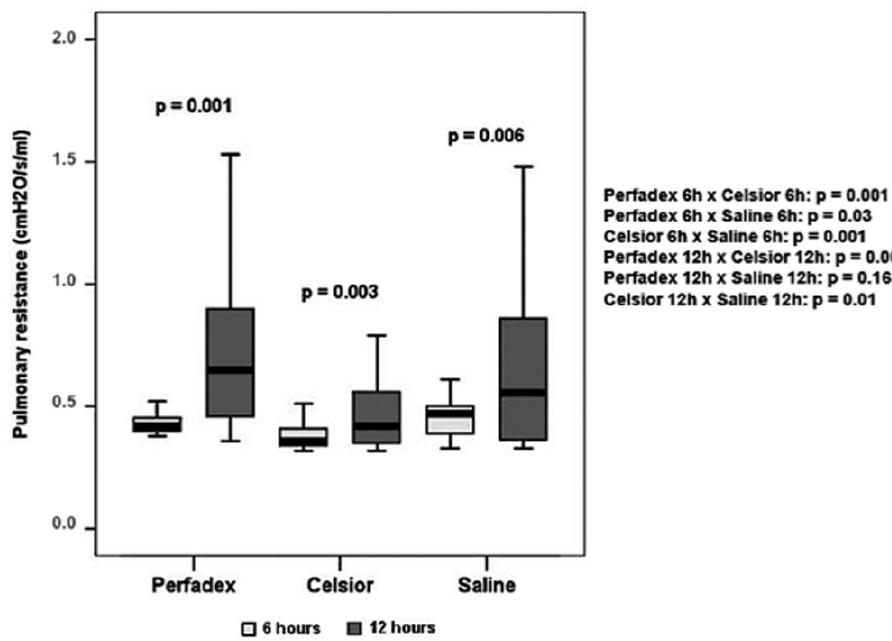
Figure 3 - Airway resistance of rat lungs subjected to ischemia and reperfusion for 60 minutes. The Celsior lungs exhibited the lowest airway resistance for both ischemic times. The airway resistance was lower in lungs submitted to 6 hours of ischemia compared with those submitted to 12 hours of ischemia.